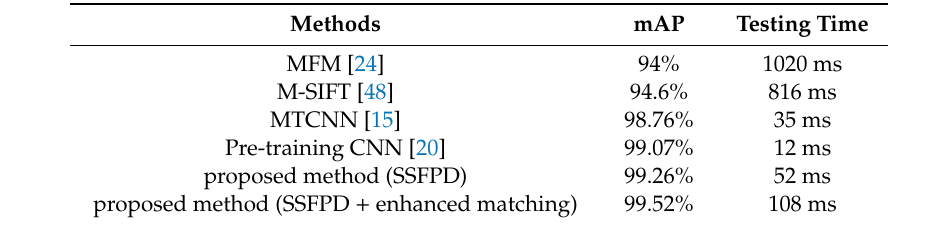
Table 7. Accuracy comparison on public dataset.